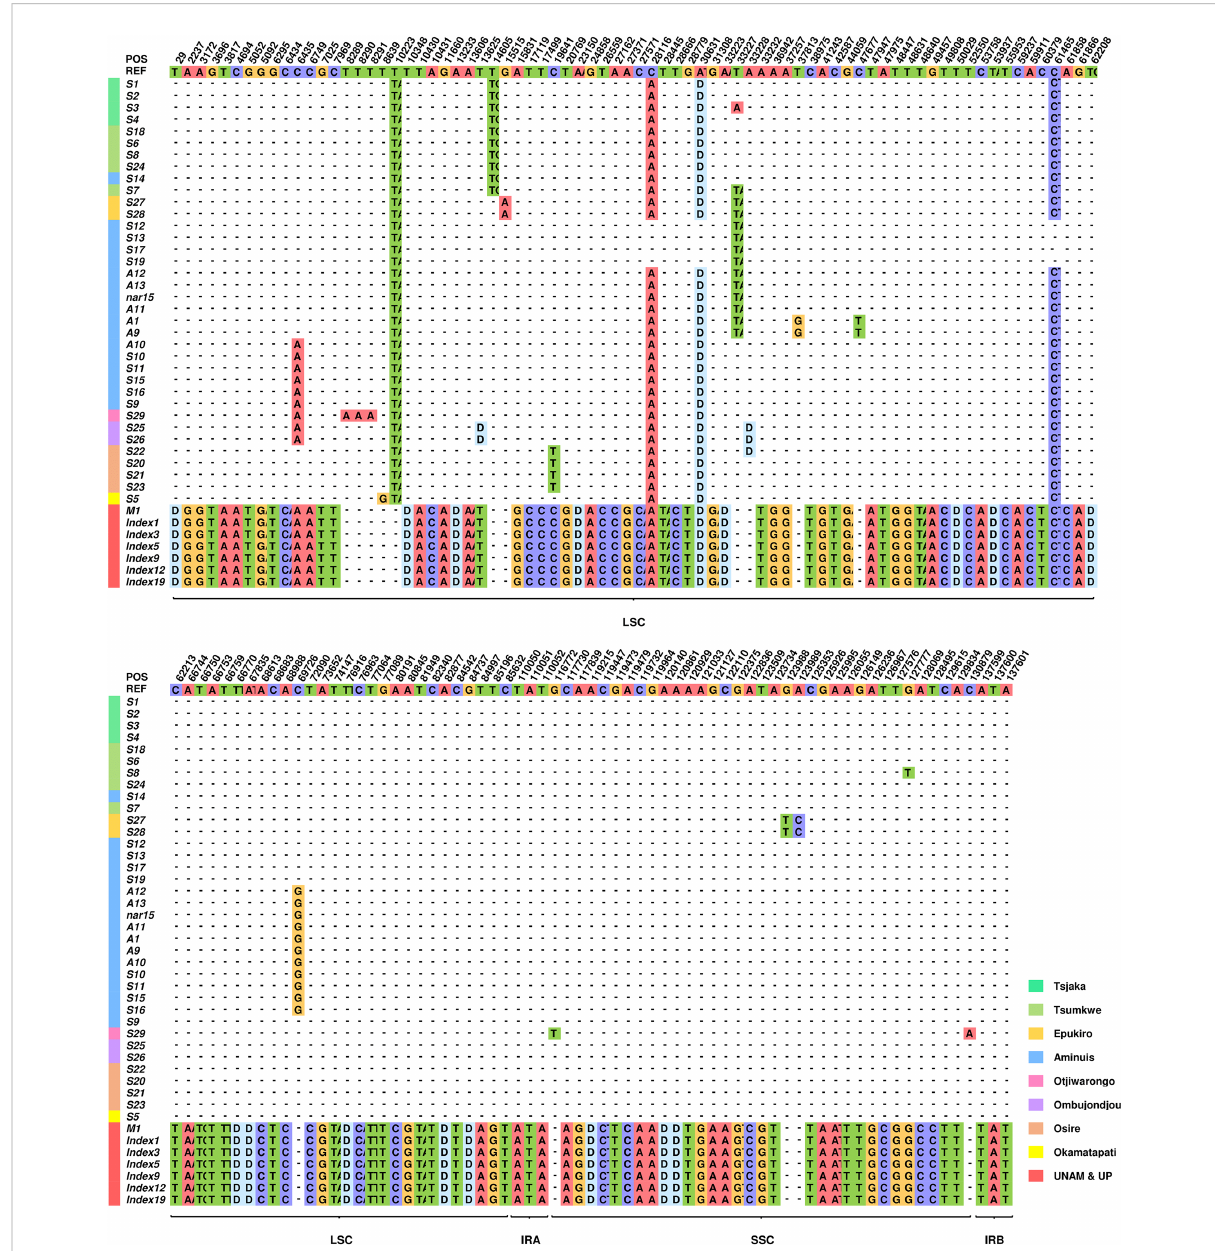
FIGURE 3 Distribution map of all variations in 43 independent T. esculentum individuals. This fi gure includes only loci that differ in these plants, and the top row shows the sequence of the reference genome. Only bases different from the reference are exhibited, others are represented by dashes. To save space, only the fi rst two bases of insertions are displayed. The letter D means deletions. The color bar to the left of the plant ID shows the source of the